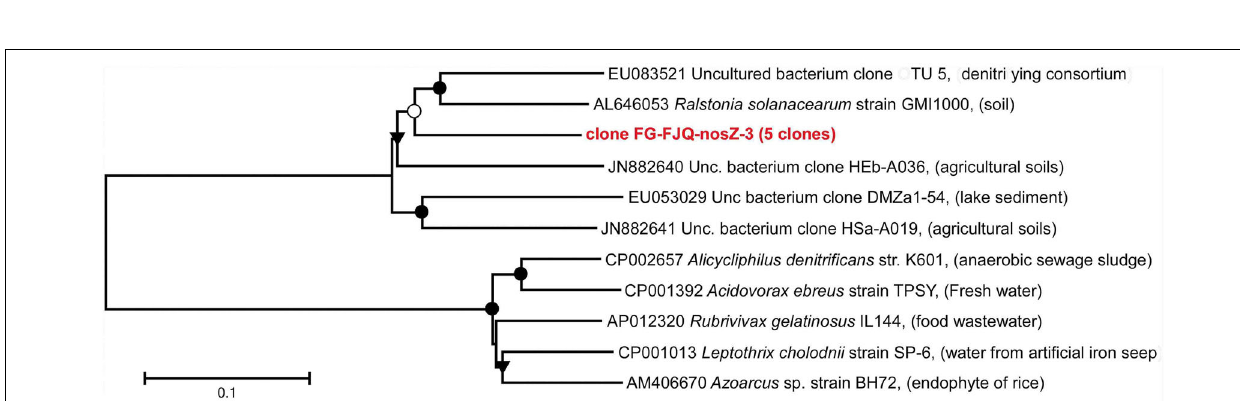
FIGURE 7 | Phylogenetic relationships of cnorB and qnorB gene fragments obtained from microcosms of the spring FJQ. The tree was generated by neighbor-joining analysis of 450 nucleotide